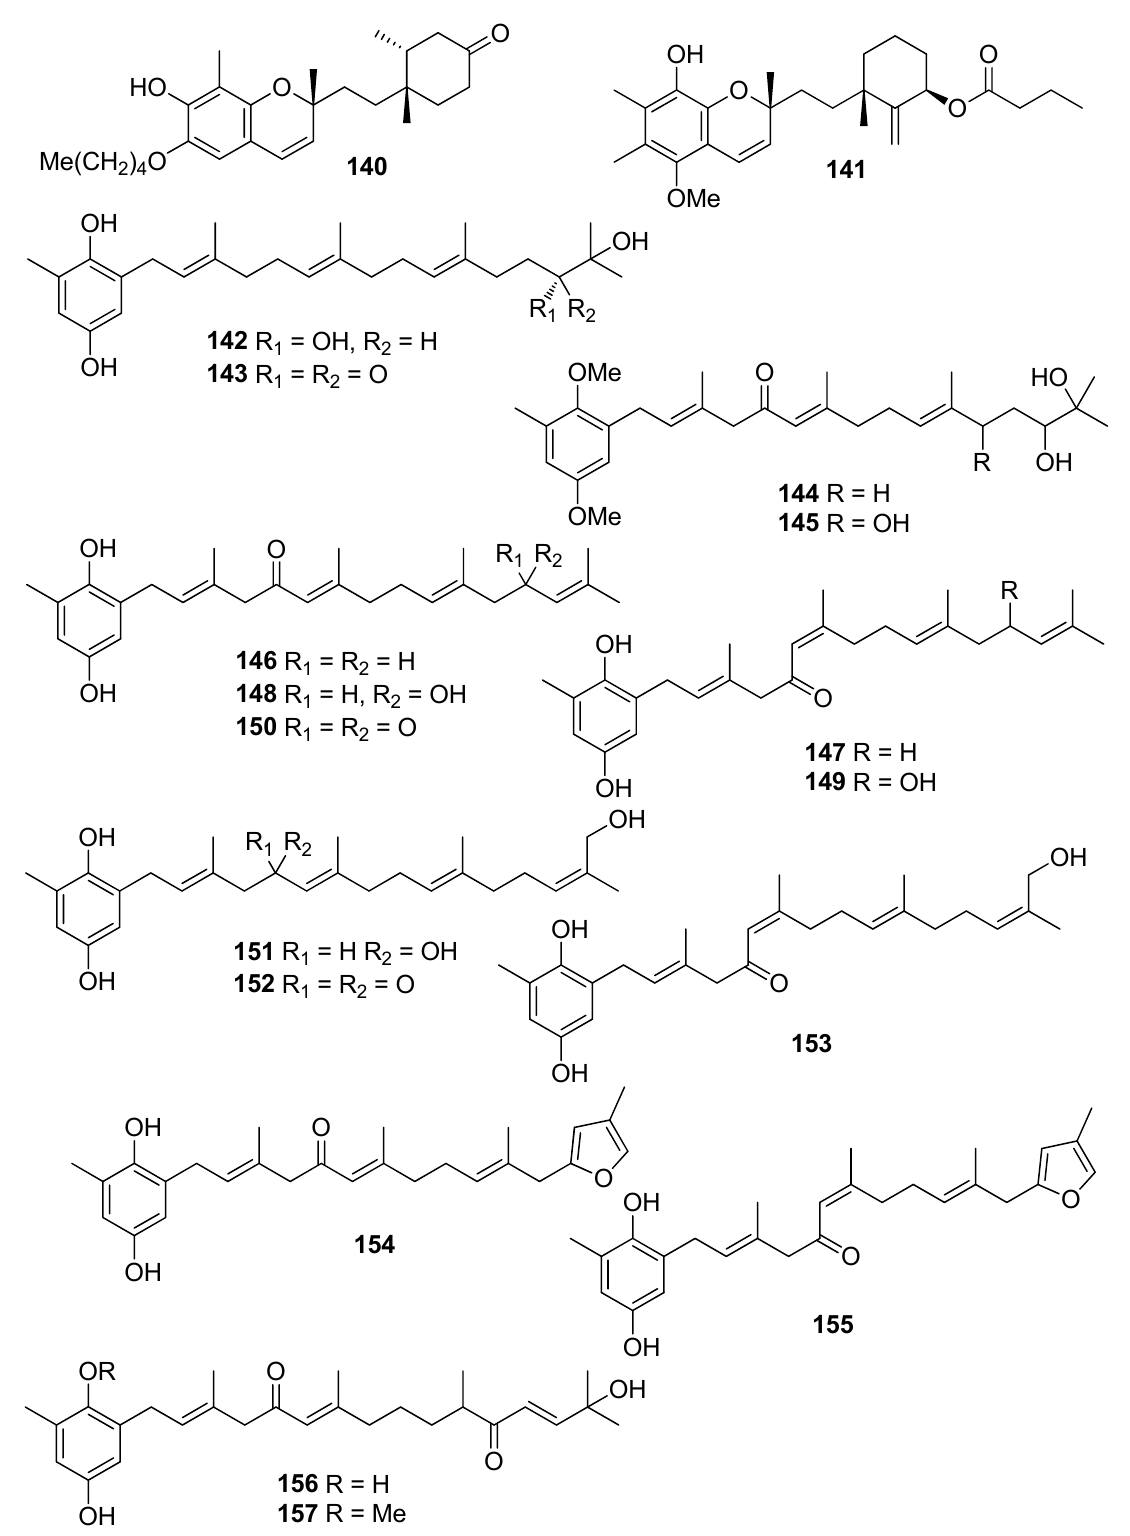
Figure 14. Chemical structures of compounds 140 – 157 .